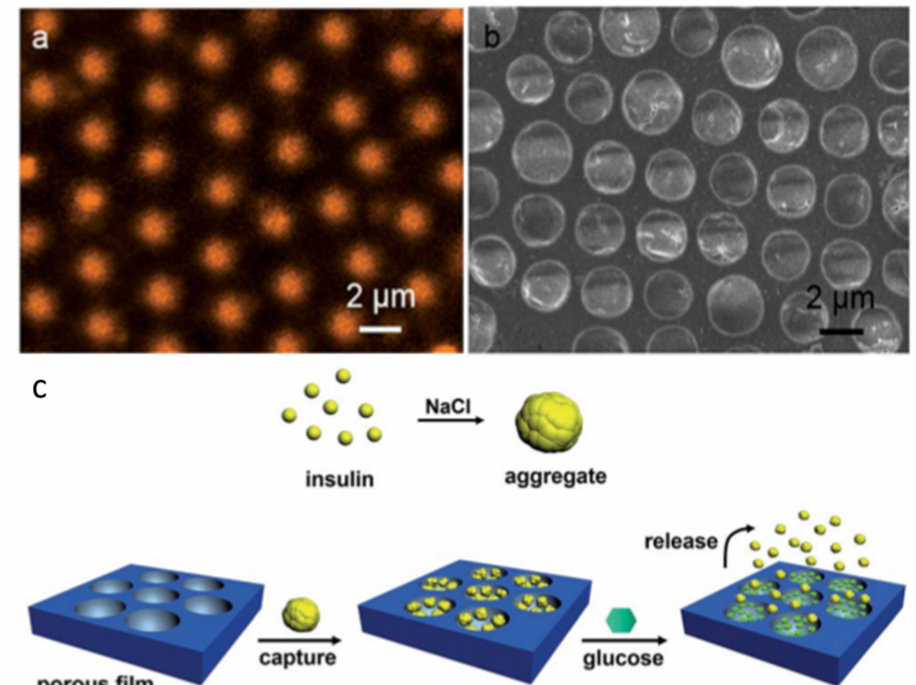
Figure 6. ( a ) CLSM images of PBA-PAA/PS porous film after their immersion in ARS dye solution. ( b ) SEM image of porous PS film loaded with insulin aggregates after immersion in 0.8 M NaCl aqueous solution at pH 5.3 at 25 ◦ C. ( c ) Scheme of the capture of glucose and the glucose-responsive release of insulin aggregates. Reprinted with permission from ref. [95]. Copyright 2015 Journal of Materials Chemistry B.